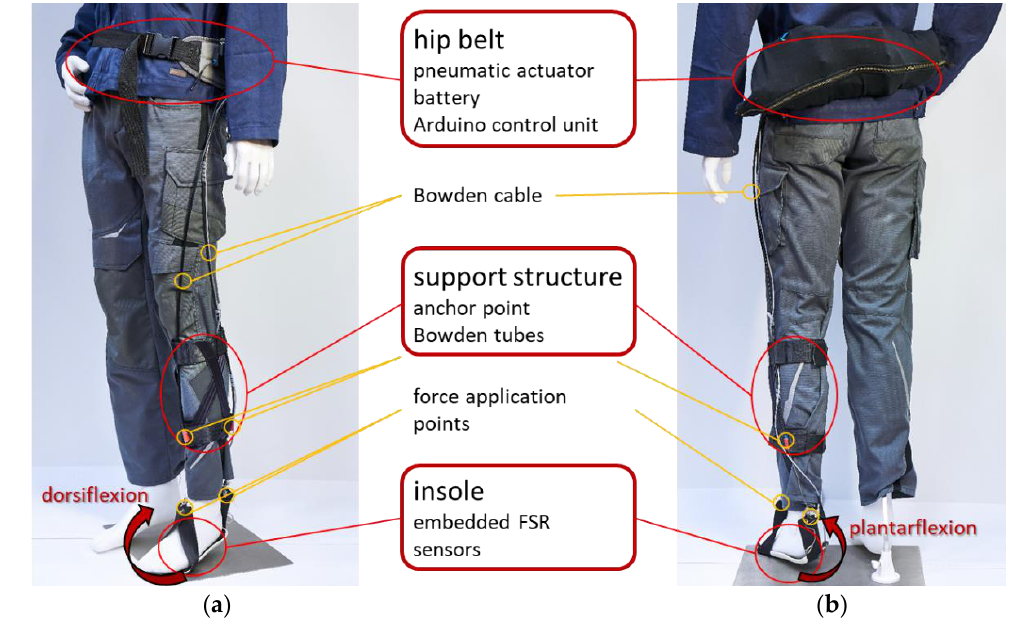
Figure 2 . ( a ) Frontal view and ( b ) rear view of underbody